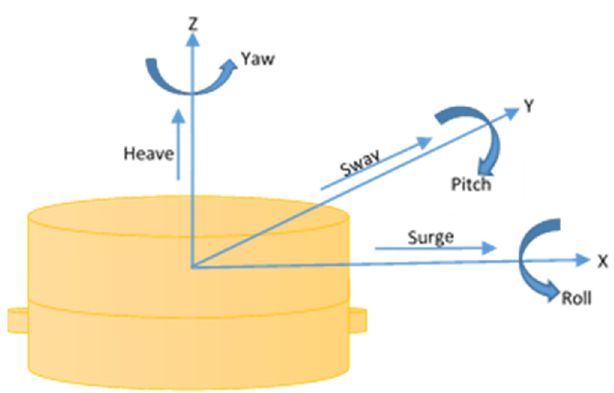
Figure 3. The six degrees of freedom of a floating CALM buoy